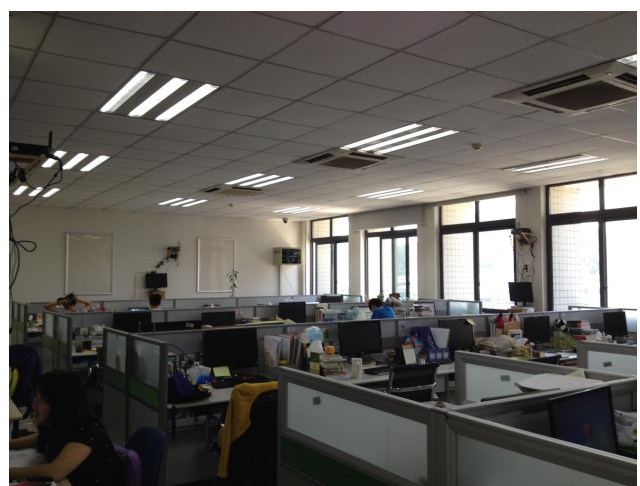
Figure 12. Picture of the